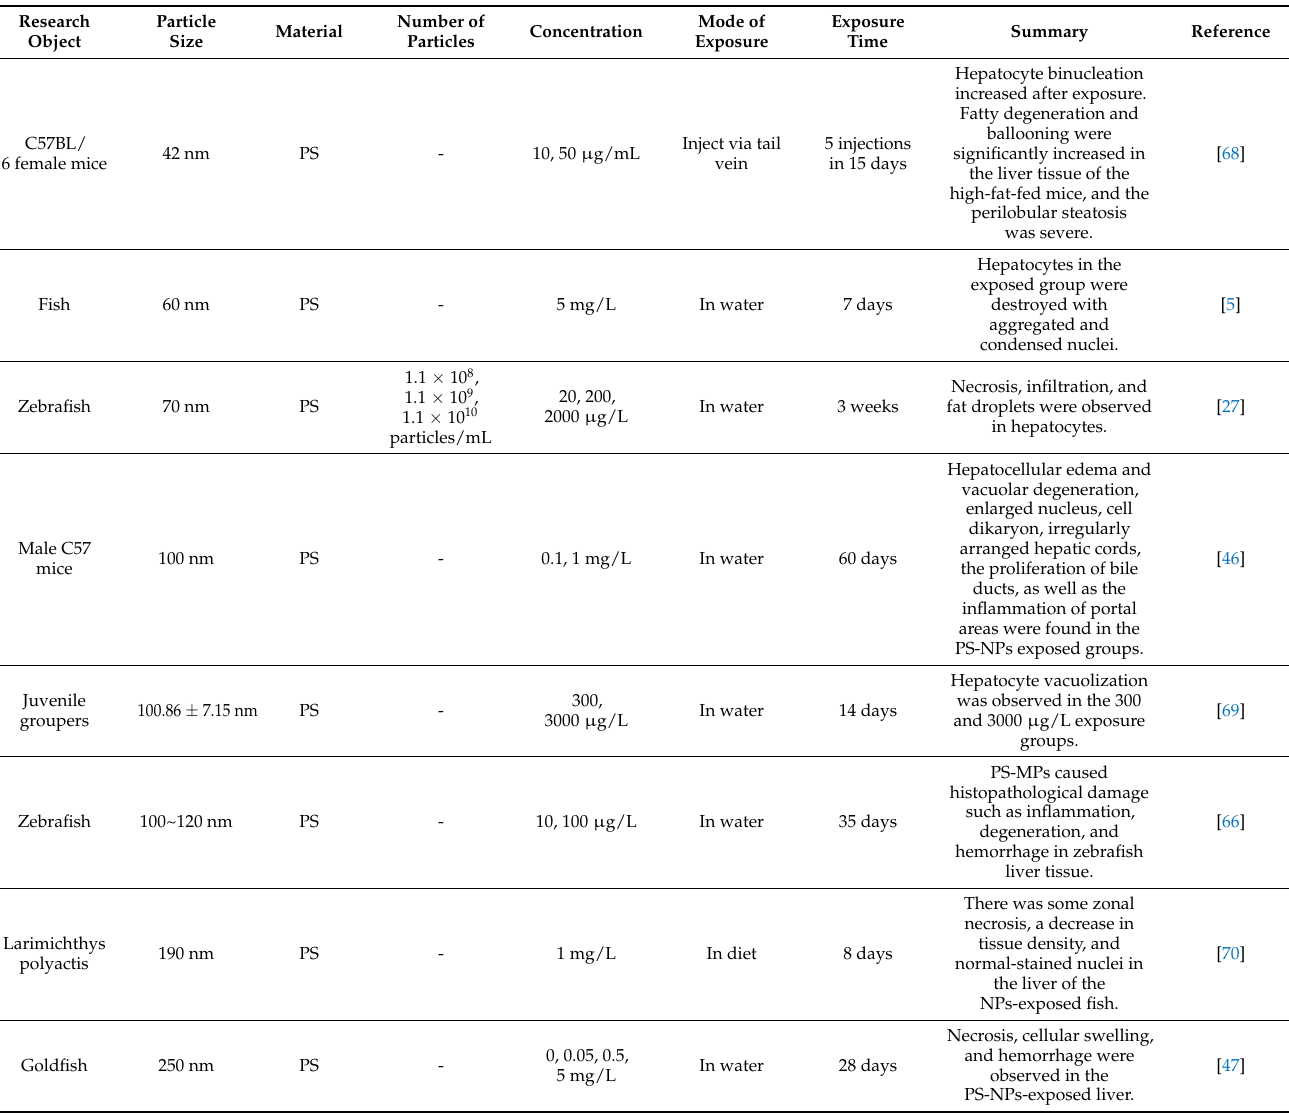
Table 3. The study parameters and effects of hepatic pathomorphological changes caused by NPs on the